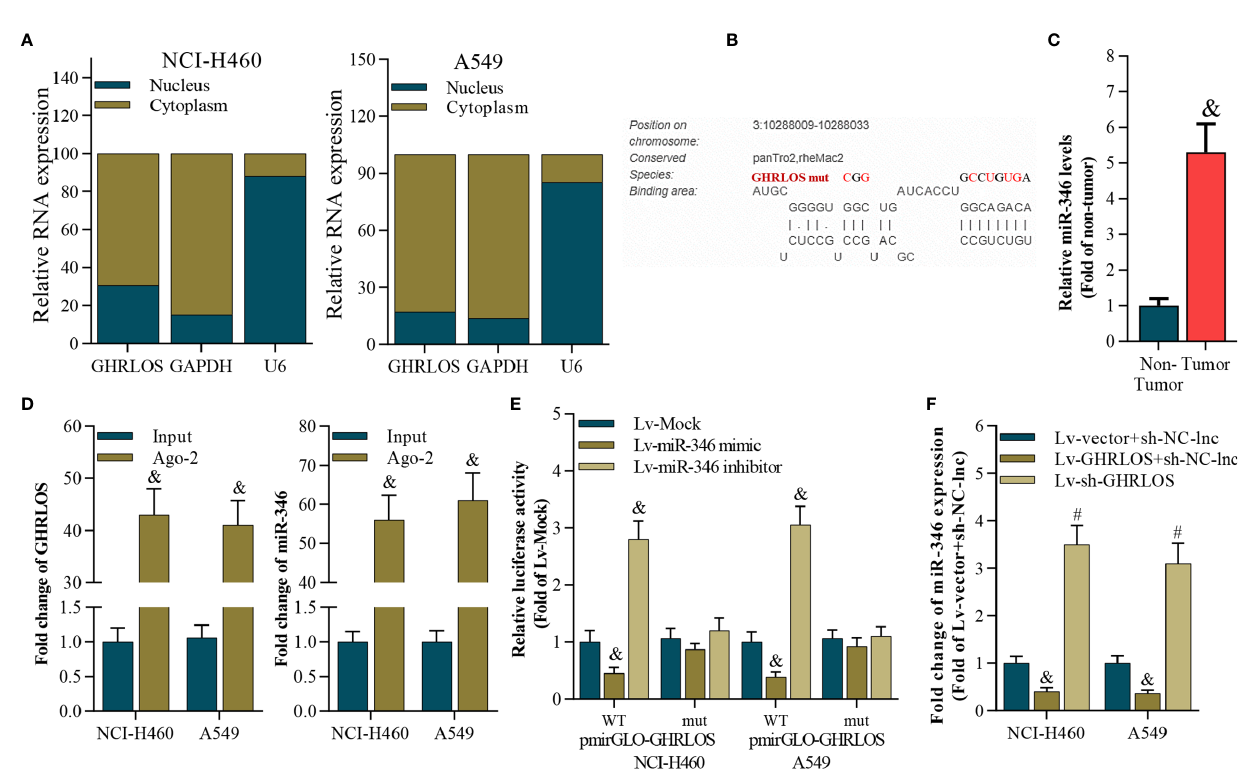
FIGURE 4 | LncRNA GHRLOS is a molecular sponge of miR-346. (A) qRT-PCR analysis of subcellular localization of lncRNA GHRLOS. GAPDH was used as an internal cytoplasmic control, and U6 served as an internal nuclear control. (B) qRT-PCR analysis of miR-346 in clinical NSCLC tissues, &p< 0.01 vs. non-tumor. (C) The predicted binding site between lncRNA GHRLOS and miR-346 was obtained. (D) qRT-PCR analysis on the expression of lncRNA GHRLOS and miR-346 after anti-Ago2-mediated RIP assays in A549 and NCI-H460 cells, &p< 0.01 vs. input. (E) Dual luciferase reporter assay on the interaction between lncRNA GHRLOS and miR-346 after infection with Mock, miR-346 mimic, or miR-346 inhibitor for 48 h, &p< 0.01 vs. Lv-Mock. (F) qRT-PCR analysis of miR-346 after indicated infection for 48 h in A549 and NCI-H460 cells, &p< 0.01 vs.